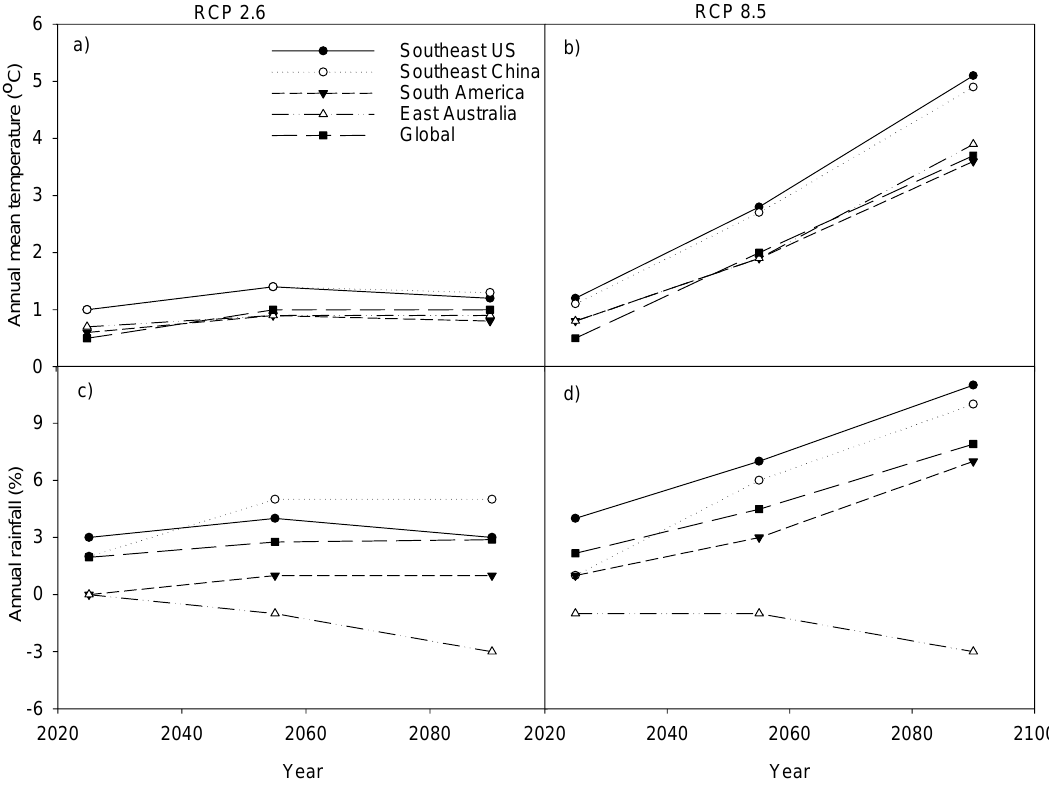
Figure 6. Projected changes in annual mean temperature for the ( a ) representative concentration pathway (RCP) 2.6 and ( b ) RCP 8.5, as well as annual mean rainfall for ( c ) the RCP 2.6, and ( d ) RCP 8.5 for humid subtropical regions in the southeast U.S., southeast China, South America, and east Australia, according to regional projections from the Coupled Model Intercomparison Project Phase 5 (CMIP5), relative to the period from 1986 to 2005. The mean temperature and rainfall change are averaged over all projection models for 2016–2035, 2046–2065, and 2081–2100, and compared to 1986 to 2005 period. Values indicate 50th percentile of mean responses of the model ensemble used for each RCP projection: RCP 2.6 with 32 models and RCP 8.5 with 39 models [57] .